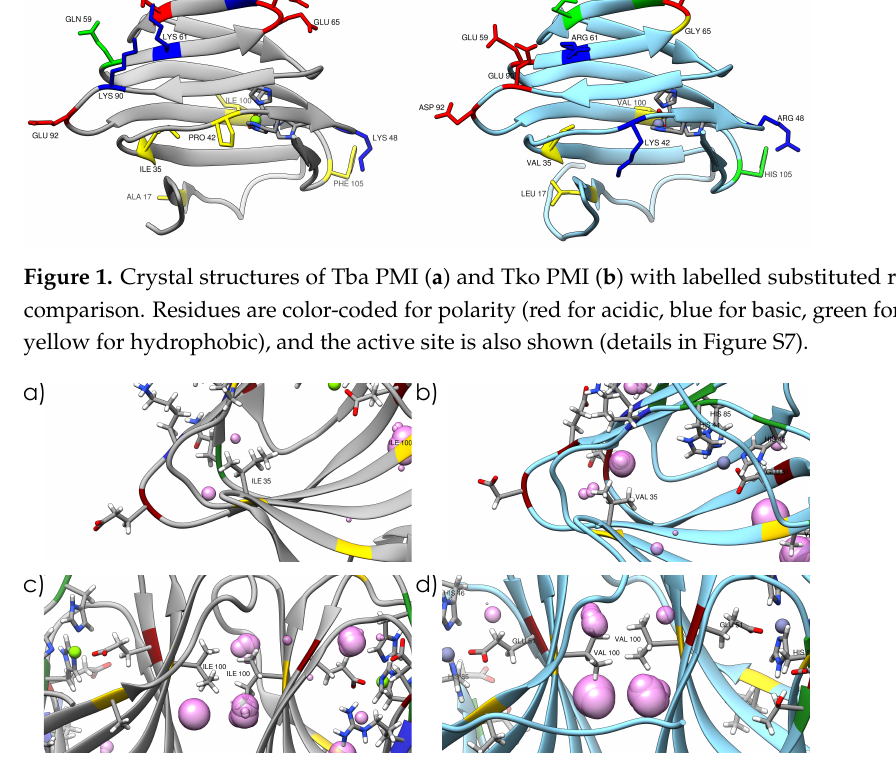
Figure 2. Internal cavities in the two proteins located near Ile-Val substitutions in the protein core ( a , b ) and at the dimer interface ( c , d ) after the relaxation of the crystal structures by MD at 310 K and 1